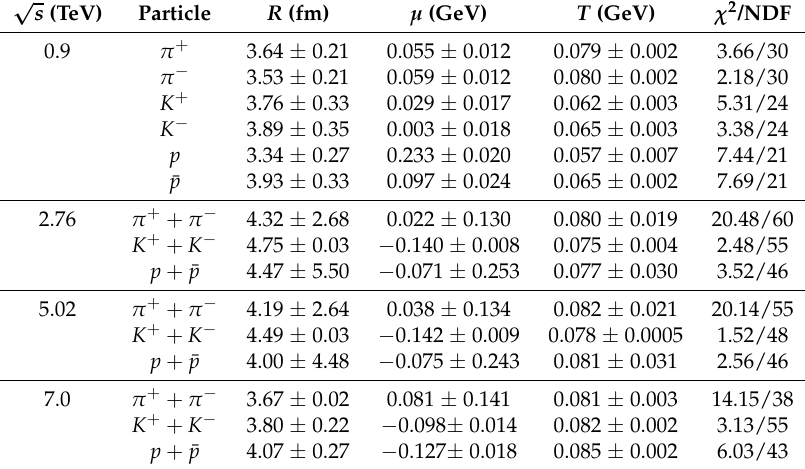
√ s = 0.9 [19], 2.76 [20], 5.02 [21] and 7 TeV [21,22], using data from the ALICE Table 2. Fit results at Collaboration with q from Table 1 following Equations (2) and